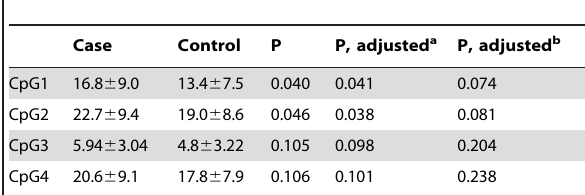
Table 4. Pyrosequencing results of SULF1 gene in GA